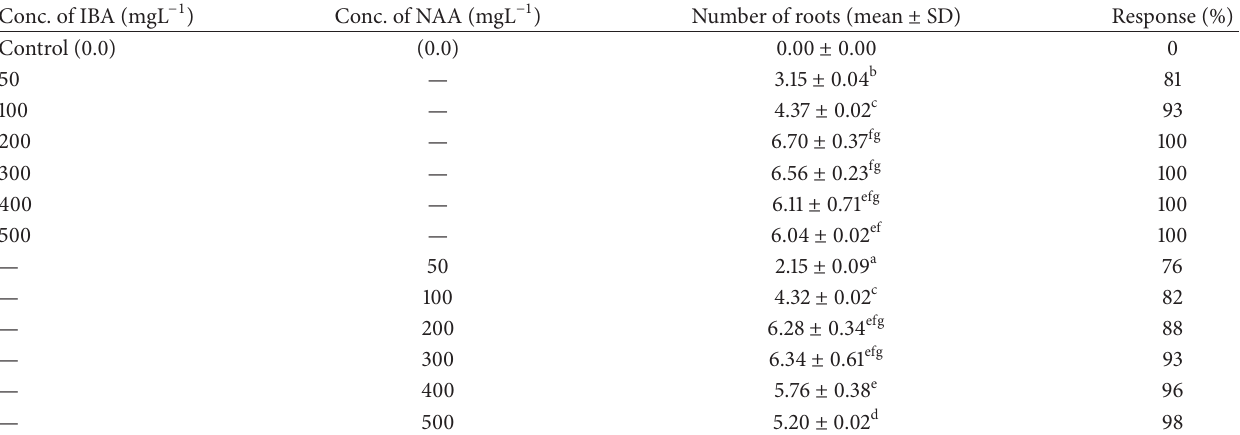
Table 5: Effect of auxins (IBA, NAA) on ex vitro roots induction in the greenhouse after 5 weeks. Conc. of IBA (mgL −1 ) Conc. of NAA (mgL −1 ) Number of roots (mean ± SD) Response (%) Control (0.0) (0.0) 0.00 ±